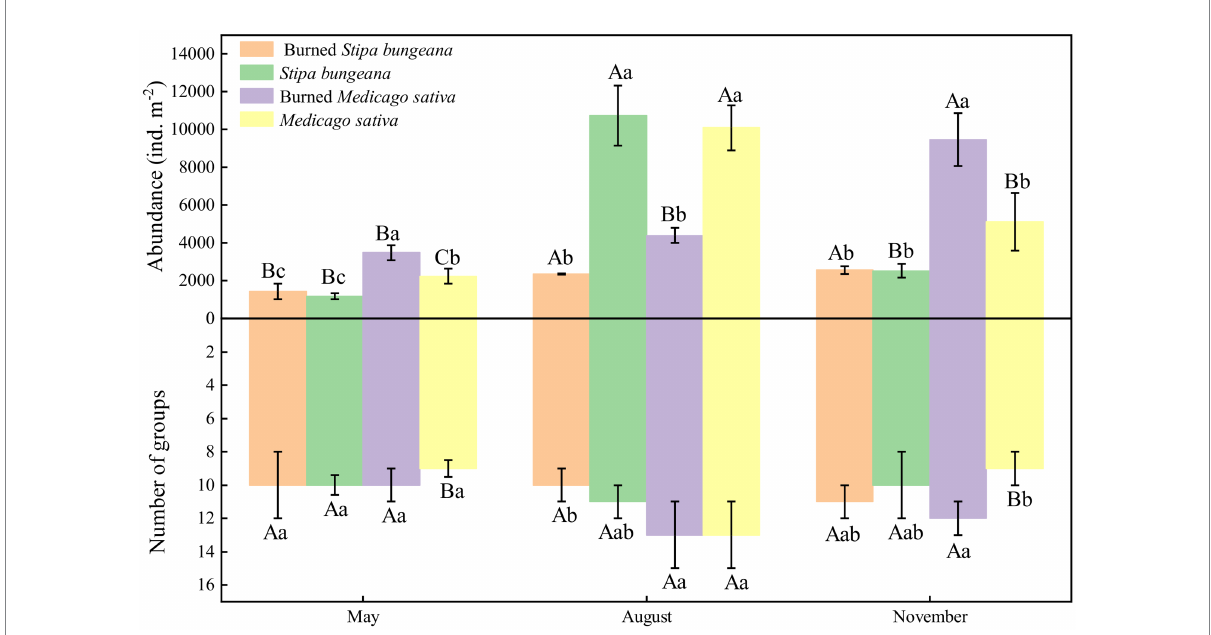
FIGURE 2 Dynamics of soil arthropods abundance and group numbers in Stipa bungeana , Burned Stipa bungeana , Medicago sativa , and Burned Medicago sativa habitats. Different lowercase letters indicate significant difference among different habitat types at the same sampling period ( p < 0.05, Duncan’s test). Different uppercase letters indicate significant difference among different sampling periods at the same habitat ( p < 0.05, Duncan’s